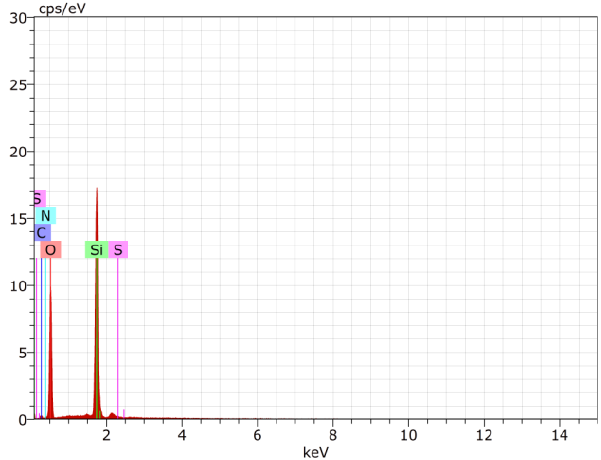
Figure 13. EDX of the of functionalized organic-inorganic nano composites (11) .